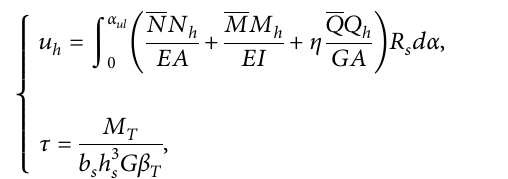
Figure 5: Wedge under the lifting